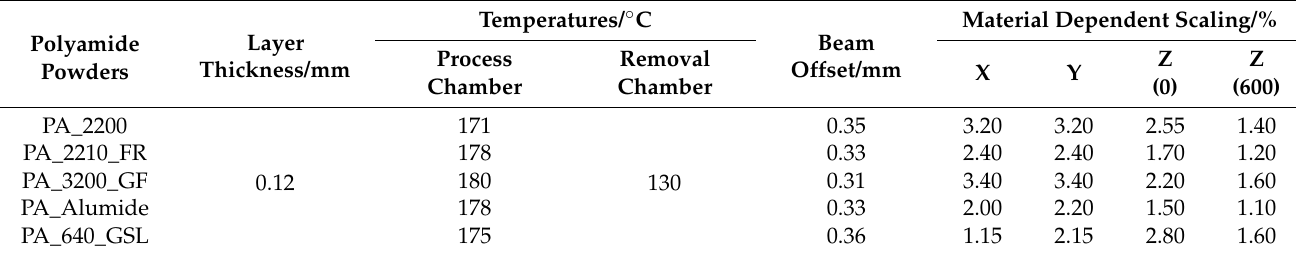
Table 3. Printing